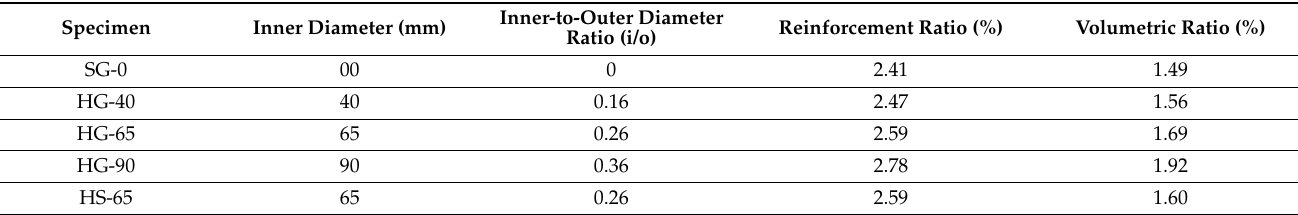
Table 2. Size and reinforcement details of tested column specimens.